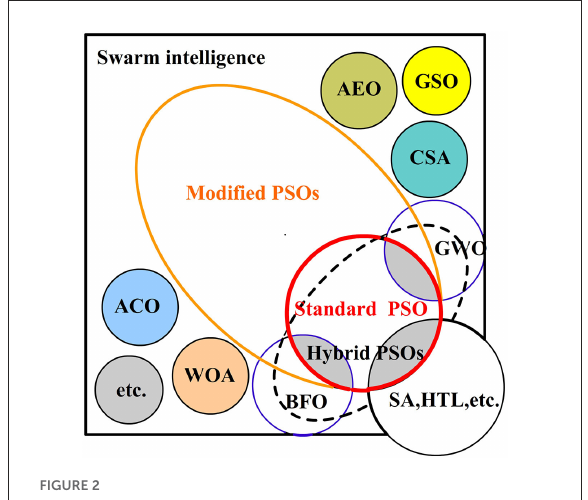
FIGURE2 The diagram of existing swarm intelligence algorithms applied to multi-robot system for odor source localization.